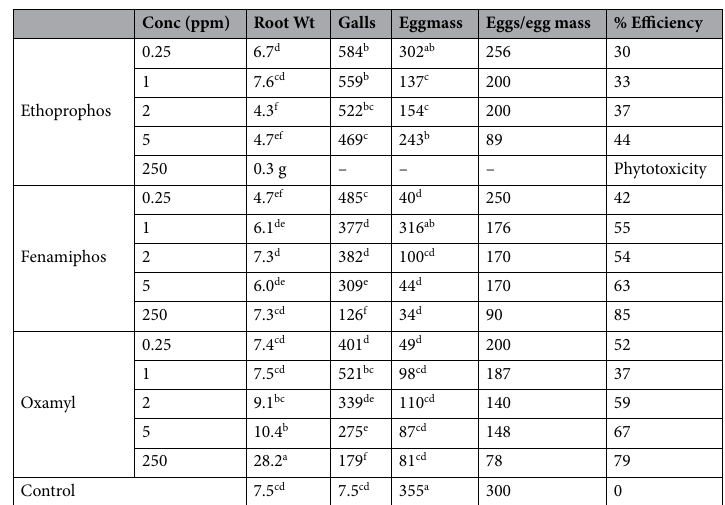
Table 1. Effects of sublethal chemical nematicide concentrations on the infectivity and fecundity of Meloidogyne incognita on potted eggplant. Means in the same column followed by a different letter(s) are significantly different at p < 0.05 according to Duncan’s multiple range tests.